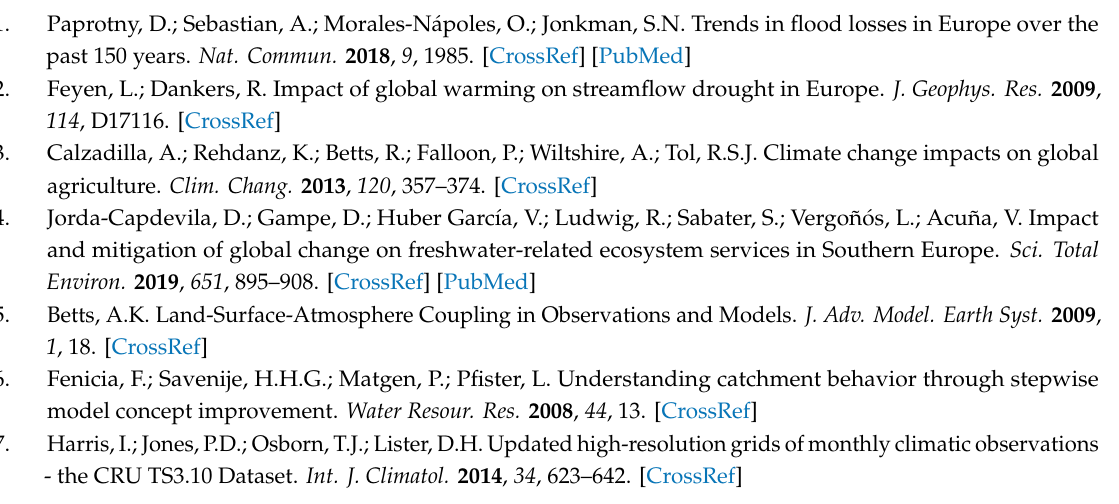
Figure S1: Baseline maps of Q H100 (a), Q M (b), Q L15